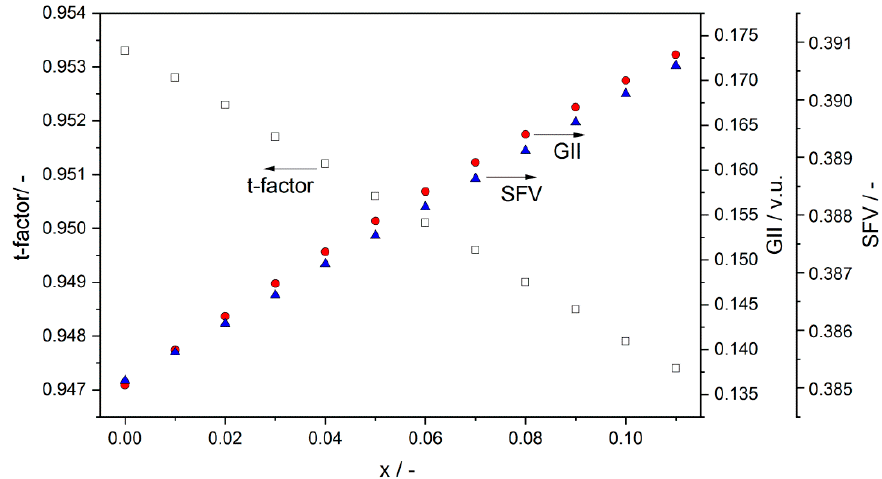
Figure 3. Dependence of the t tolerance factor, specific free volume SFV, and global instability index GII vs strontium content in Ba 1 − x Sr x Ce 0.9 Y 0.1 O 3 − δ samples.